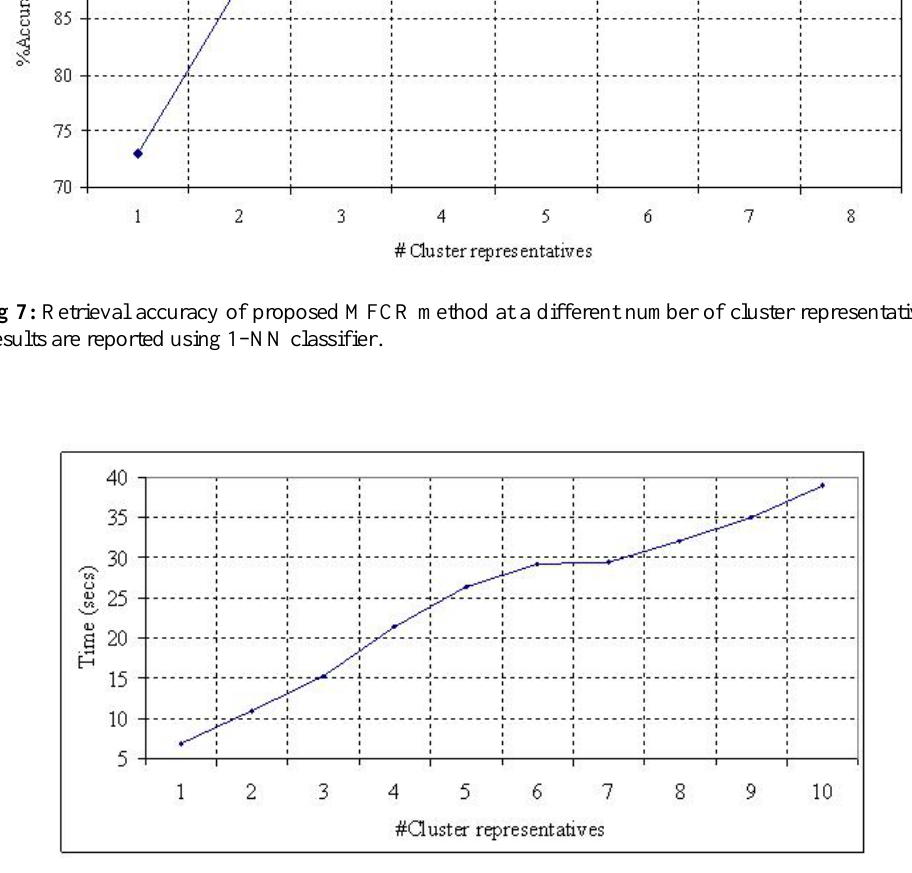
Fig 8: Average retrieval time of proposed MFCR method at a different number of cluster representatives.